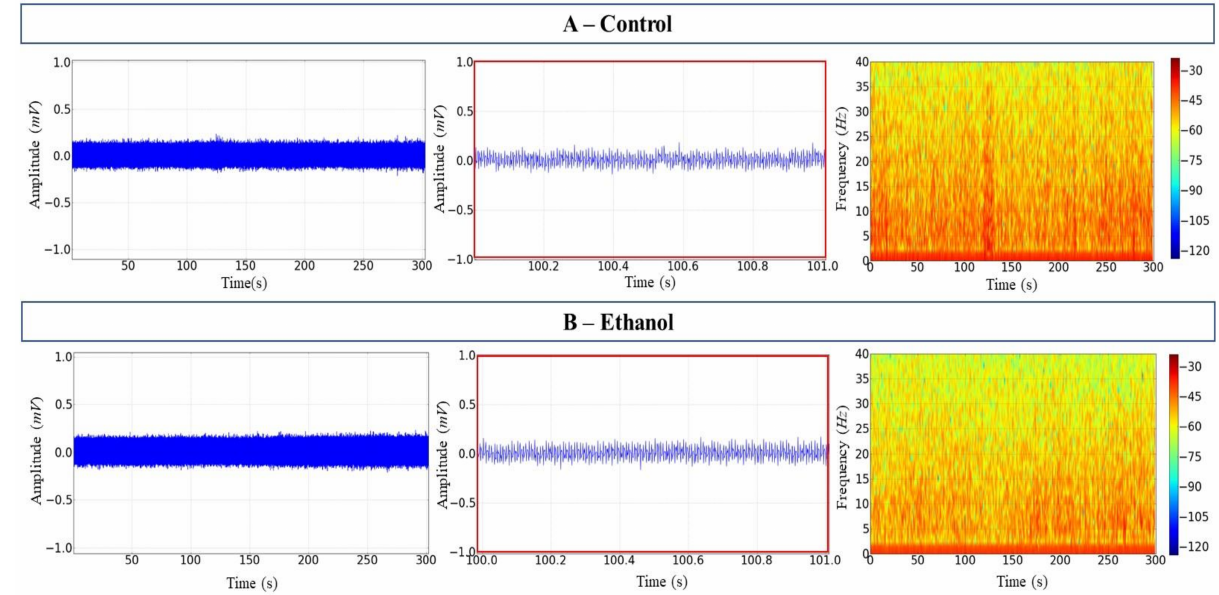
Figure 1. Tambaqui C. macropomum midbrain electroencephalographic (EEG) records. ( A ) Control records over 300 s (left); 1 s snapshot amplification (centre); the spectrogram of frequency showing the distribution of power (right). ( B ) Ethanol records over 300 s (left); 1 s snapshot amplification (centre); the spectrogram of frequency showing the distribution of power (right). Amplification of 5000 × . Records from one fish only in each group.